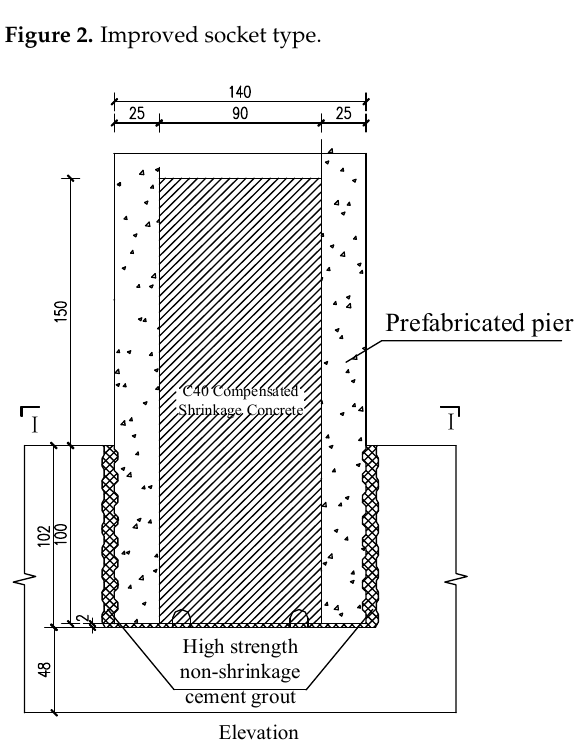
Figure 3. Concrete pier and column structure.